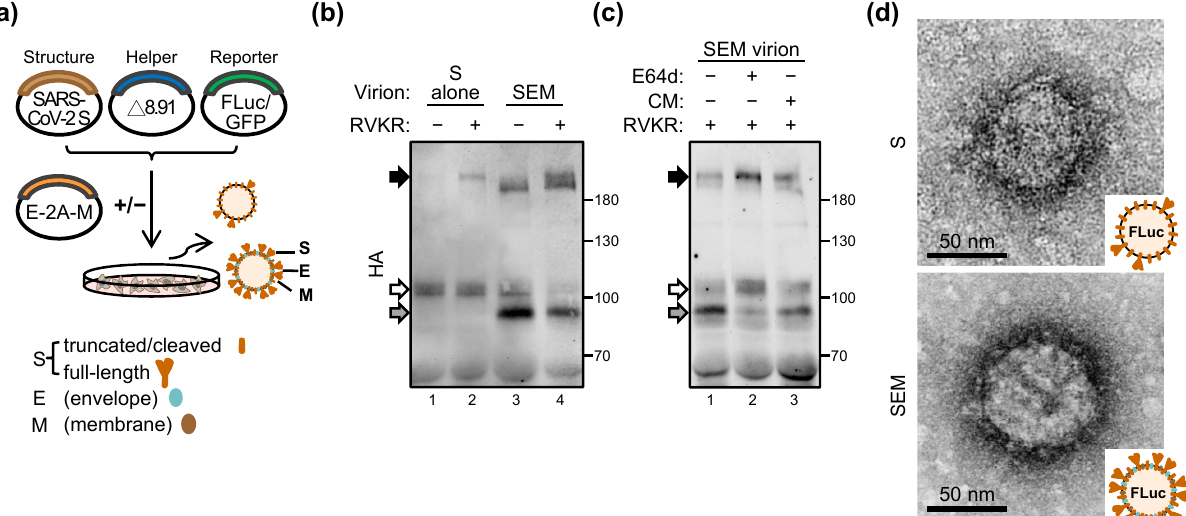
Figure 2. In trans , supplying SARS-CoV-2 E and M proteins promotes the pseudovirion S priming and contributes crown-like morphology: ( a ) schematic illustration of the pseudovirion preparation. Plasmids of SARS-CoV-2 S protein plus lenti-helper and reporter (FLuc, firefly luciferase ; GFP, green fluorescent protein) were transfected into 293T/17 cells with or without the E-2A-M construct. ( b , c ) The pseudovirions made by different preparations were analyzed by WB using the anti-HA antibody. The presence (+) or absence ( − ) of the inhibitors in each preparation are indicated. The SARS-CoV-2 S protein is C-terminal HA-tagged. RVKR, furin inhibitor (10 µ M); E64d, cathepsin L inhibitor (100 µ M); camostat mesylate (CM), TMPRSS2 inhibitor (250 µ M). Black arrow, full-length S; white arrow, furin-cleaved S; gray arrow, primed S2 (cid:48) . ( d ) Transmission electron microscopy (TEM) analysis of the pseudovirion coated with S alone (S) or with S, E and M